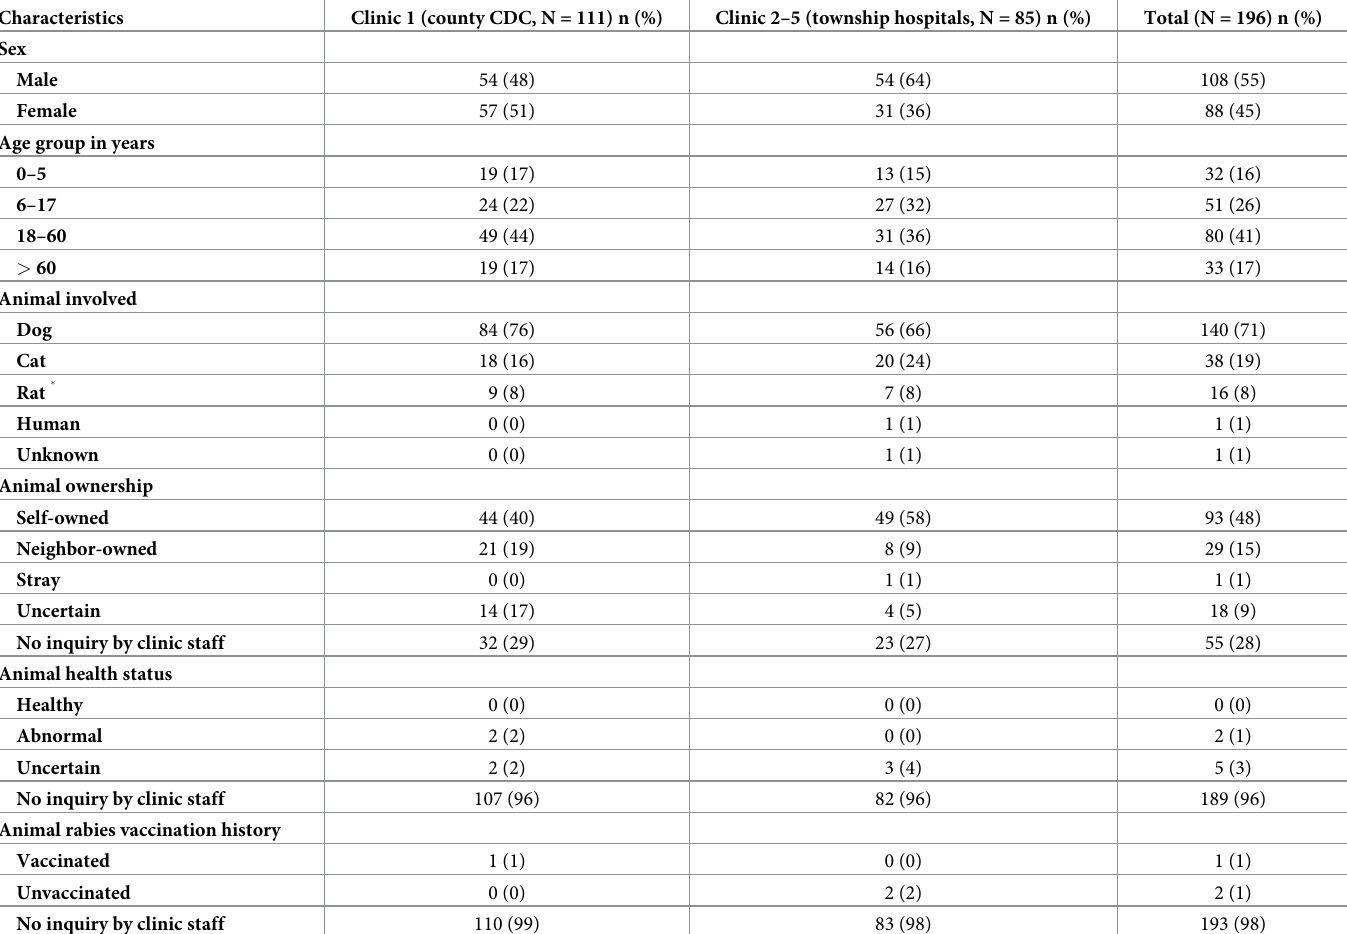
Table 2. Characteristics of patients seeking post-exposure prophylaxis (PEP) care at five selected rabies clinics in county A, Hunan Province, China, July–August of 2016. Characteristics